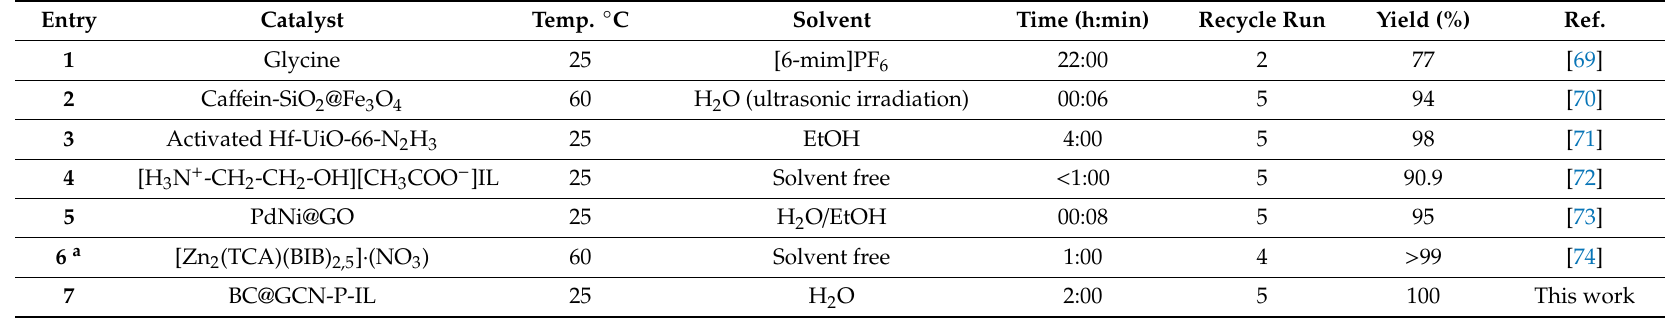
Table 2. The comparison of BC@GCN-P-IL-based procedure for the model Knoevenagel condensation reaction (malononitrile and benzaldehyde) with some reported ones